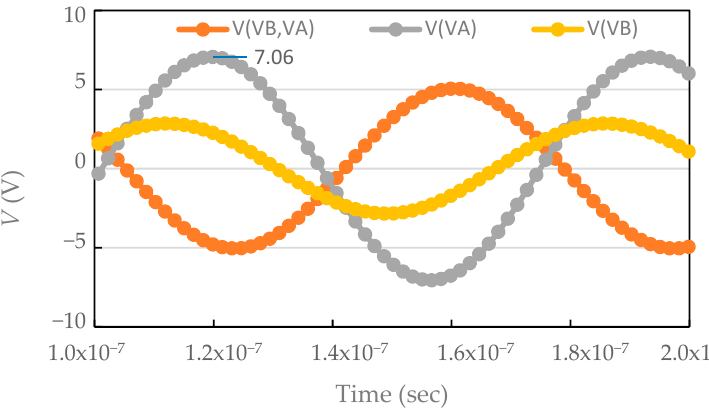
Figure 15. Voltage at the plates.